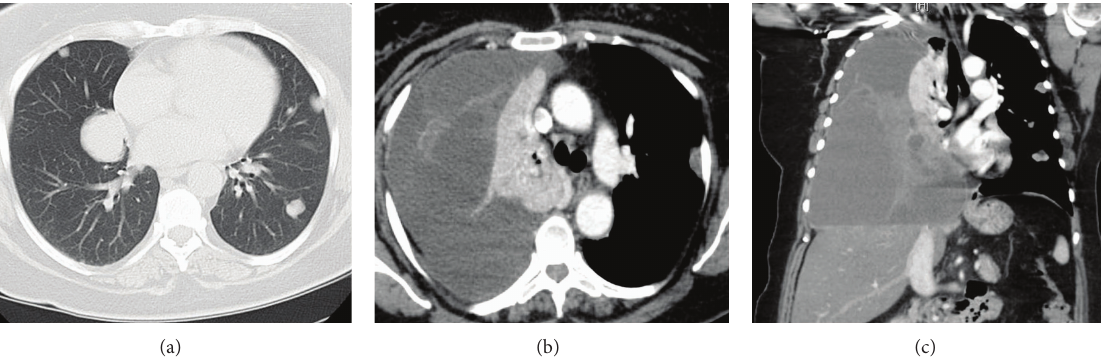
Figure 2: (a) Transverse section of thorax by CT before presentation. (b) Transverse section of thorax by CT at presentation showing fluid- filled right hemithorax with an irregular mass. (c) Coronal section of thorax by CT at presentation showing fluid-filled right hemithorax with an irregular mass.